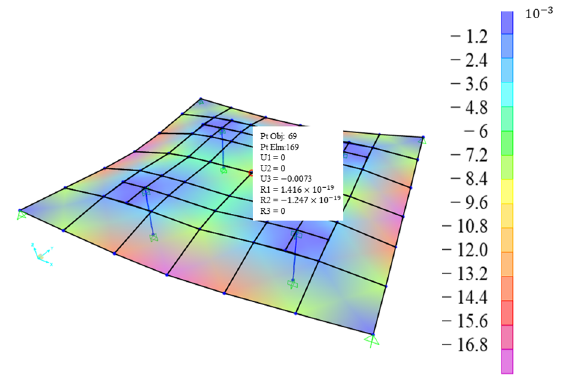
Figure 20. Structural analysis results (based on reverse engineering drawing).